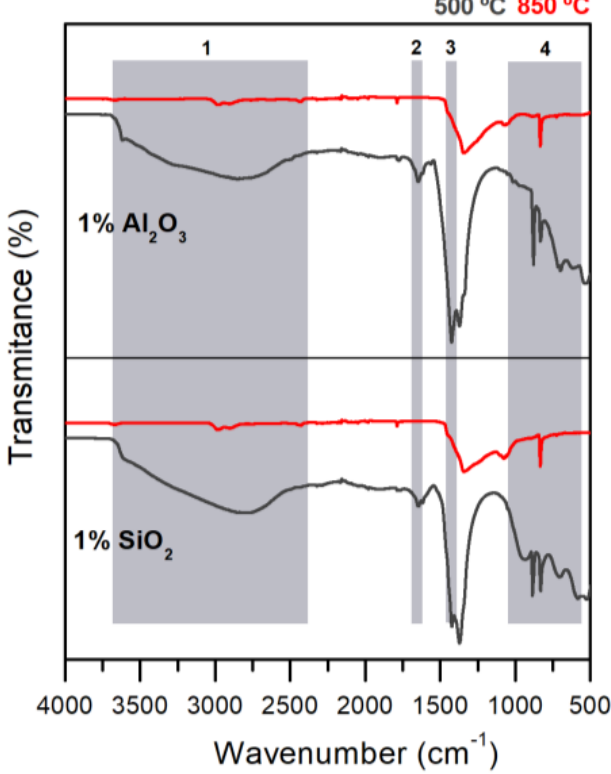
Figure 10. FT-IR spectra for ( top ) NaNO 3 /Al 2 O 3 NF (1% wt.) and ( bottom ) NaNO 3 /SiO 2 NF (1% wt.) after thermal treatment at 500 °C and 850 °C.